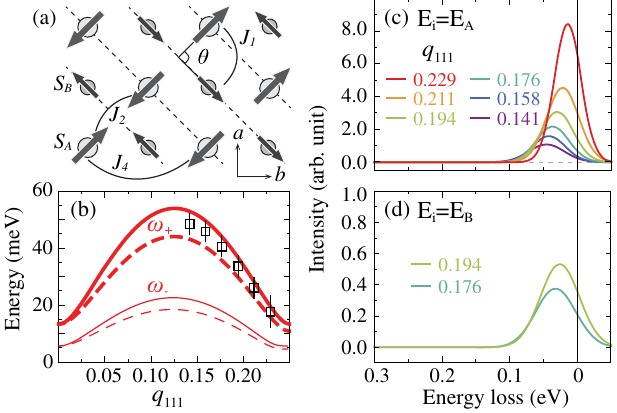
FIG. 4. (a) Schematic of the magnetic structure of R NiO 3 . It can be viewed as stacking of alternating ferromagnetic S and S A B planes along [111], as indicated by the dashed lines. (b) Calcu- lated spin-wave dispersion along [111] for two kinds of domains ¯ ¯ ¯ ¯ h k l , and dashed for h kl and hkl ). Each (solid lines for hkl and includes two branches (thick and thin) due to the disproportio- nated spins. Open symbols are experimental data from Fig. 2(f). (c,d) Calculated RIXS spectra of magnon excitations for the E experimental geometry at E and E i ¼ A B